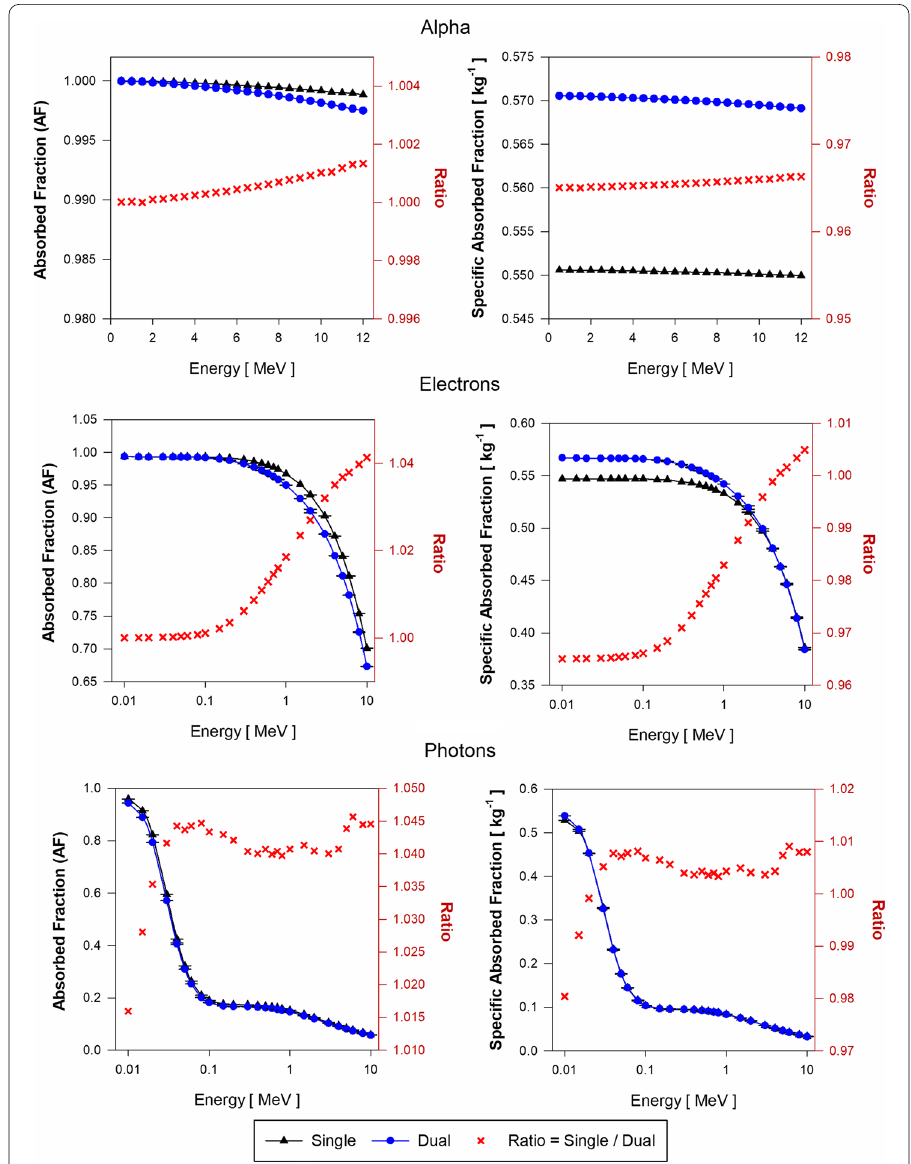
Fig. 8 Approximations of AF ( LP ← LP ) and SAF ( LP ← LP ) for monoenergetic alpha particles (Top), electrons (Center), and photons (Bottom) using the single‑region liver model (black triangles) and the dual‑region liver model (blue circles) in tetrahedral mesh‑type format for the reference adult female liver